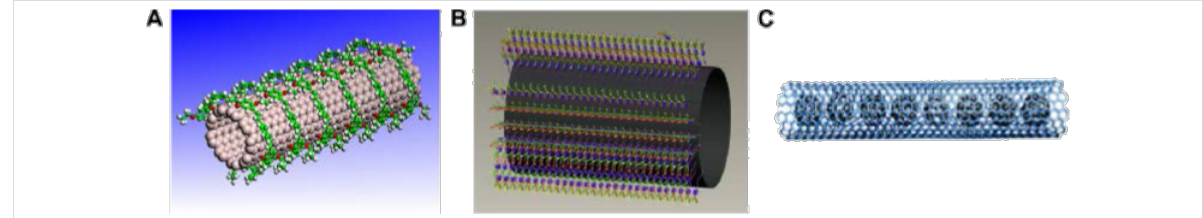
Figure 12: Schematic of non-covalent CNT functionalizations: (A) polymer wrapping, reproduced with permission from [40], copyright 2010 Elsevier; (B) surfactant absorption, reproduced with permission from [40], copyright 2010 Elsevier; and (C) endohedral CNT, reproduced with permission from [126], copyright 2002 John Wiley and Sons.